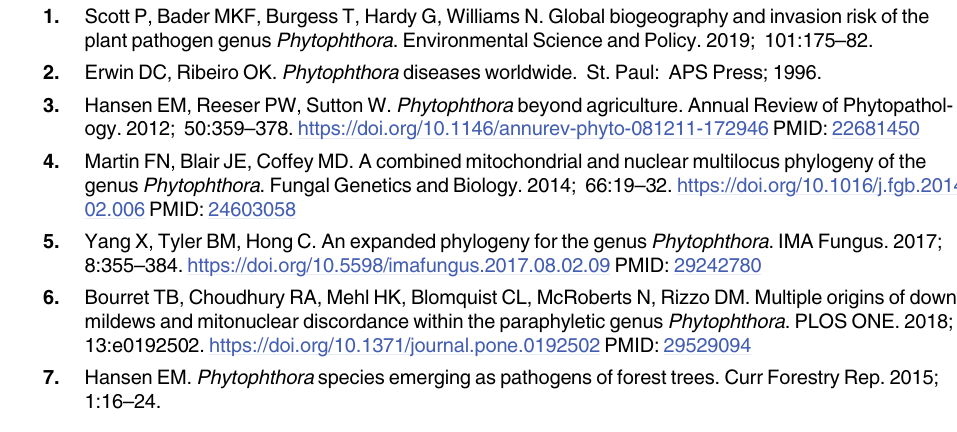
S1 Fig. Probability distributions of clock rates for P . infestans . (TIF) S2 Fig. Probability distributions of clock rates for P . agathidicida . (TIF) S1 Data. Mitochondrial genome sequences for the 21 accessions of P . agathidicida and related clade 5